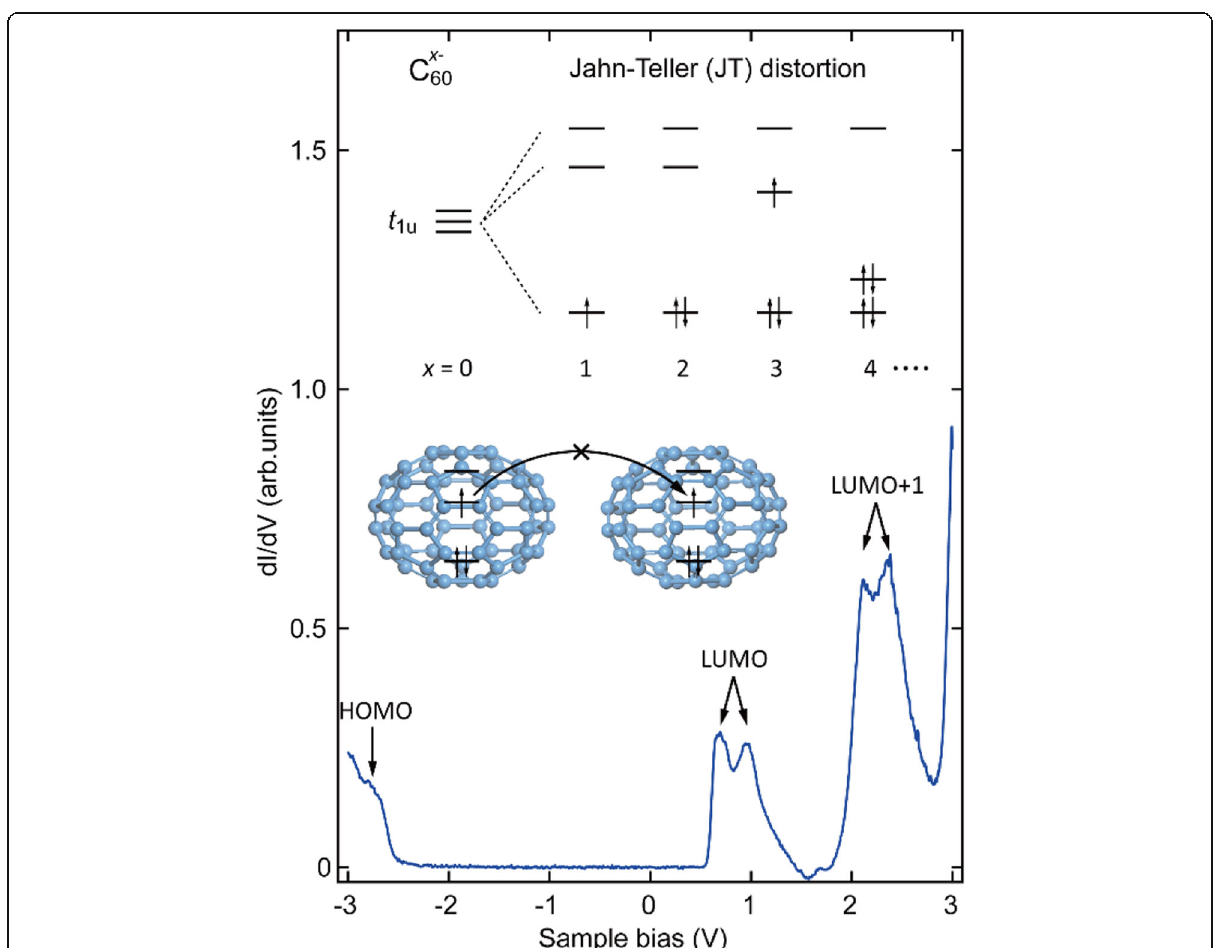
Fig. 6 d I /d V spectrum of 1 ML C 60 film grown on graphene. The inset shows the modified molecular orbitals (top) of C 60 x − anions by JT distortion (bottom). Taken from ref.